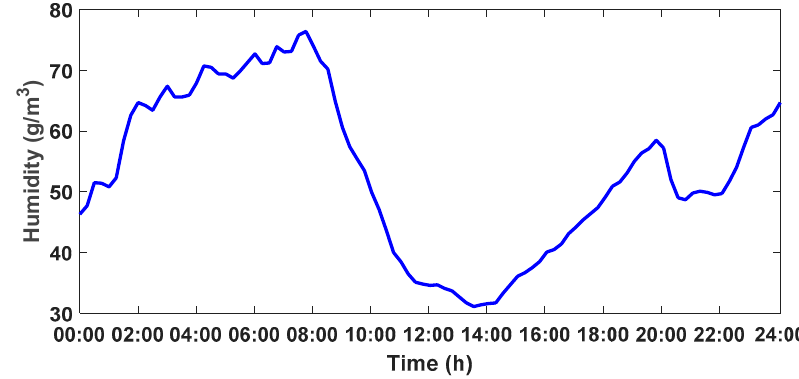
Figure 12. The outside humidity of the CSG on 26 January 2018.